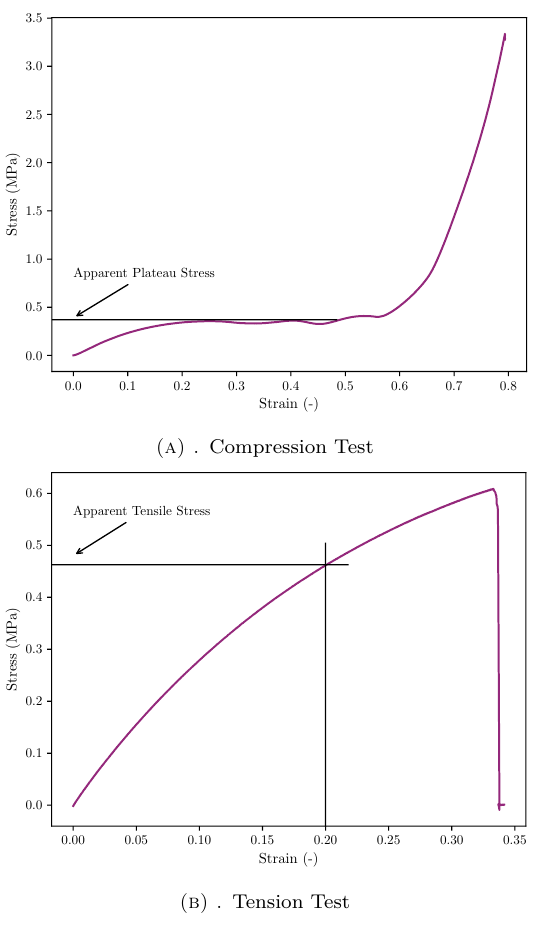
Figure 6. Evaluation of Test